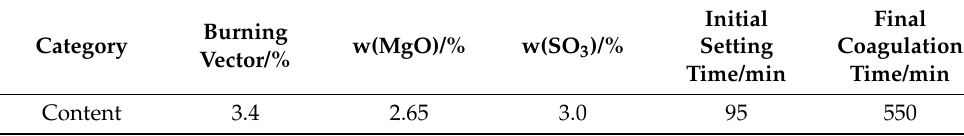
Table 1. Physical and Chemical Properties of Portland Cement.